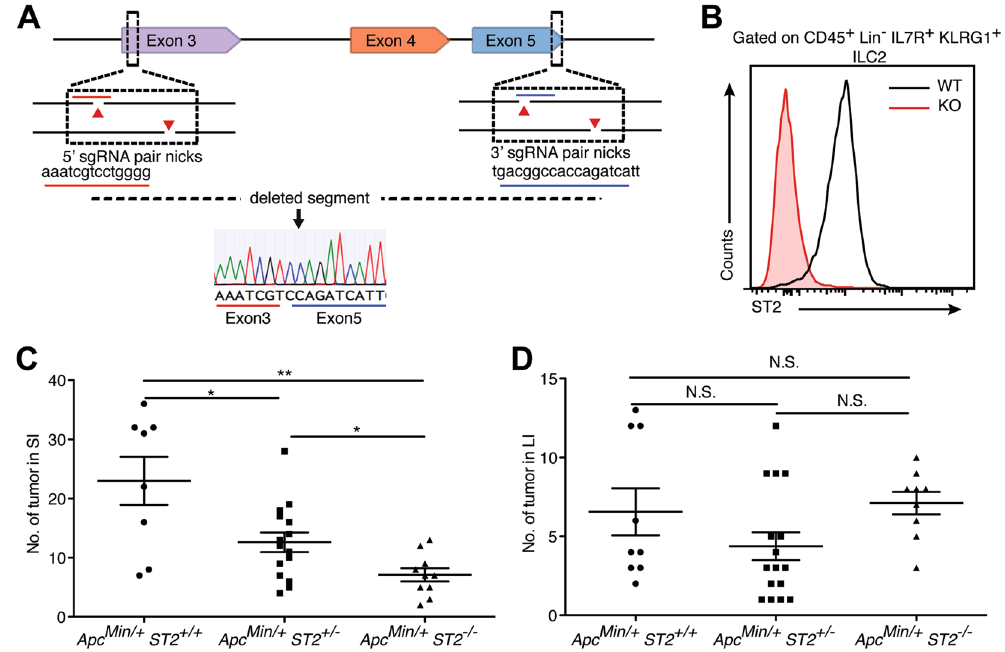
Figure 4. Genetic ablation of ST2 reduces polyp burden in Apc Min/ + mice. ( A ) Scheme for generation of ST2 − / − mice by CRISPR/Cas9n technology. The two g-RNA targeting sequences are underlined in red and blue. Sequencing confirmed the deletion of exons 4 and 5. ( B ) Flow cytometric analysis of the expression of ST2 on ILC2 (CD45 + Lin − IL7R + KLRG1 + ) isolated from the mesenteric fat of WT and ST2 − / − mice. Notice the absence of ST2 expression in the ILC2 isolated from ST2 − / − mice. ( C , D ) Quantification of the number of tumors in the small ( C ) and large ( D ) intestine of Apc Min/ + ST2 + / + , Apc Min/ + ST2 + / − and Apc Min/ + ST2 − / − mice. Graphs show means ± s.e.m. * P < 0.05, ** P < 0.01, N.S. means not significant, nonparametric Mann-Whitney